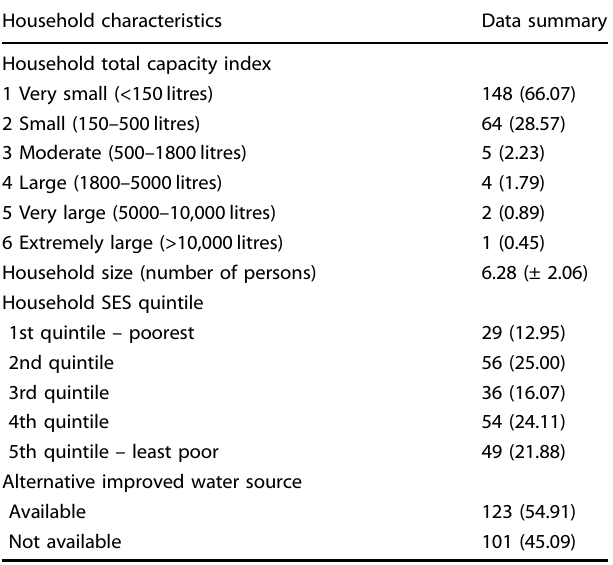
Table 1. Characteristics of study households ( n =